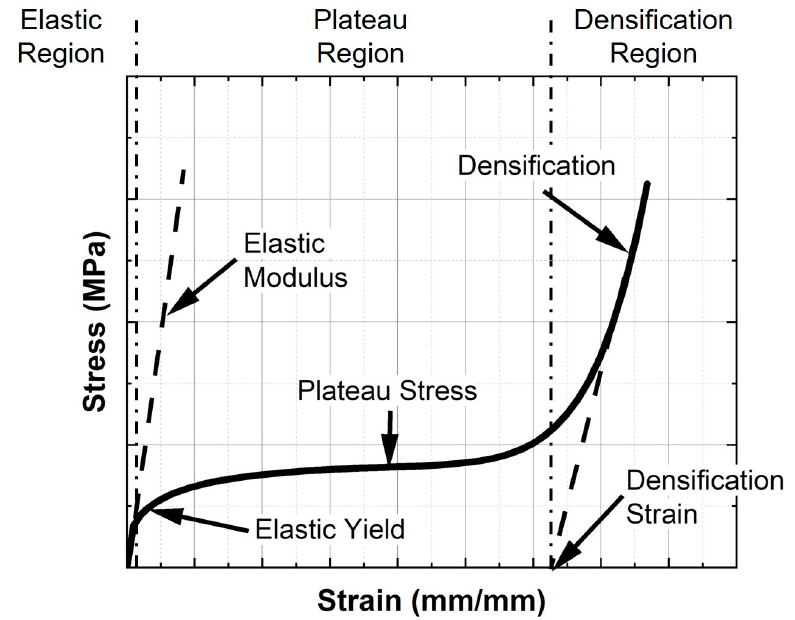
Figure 1. Typical engineering stress-strain response of a surface-based lattice